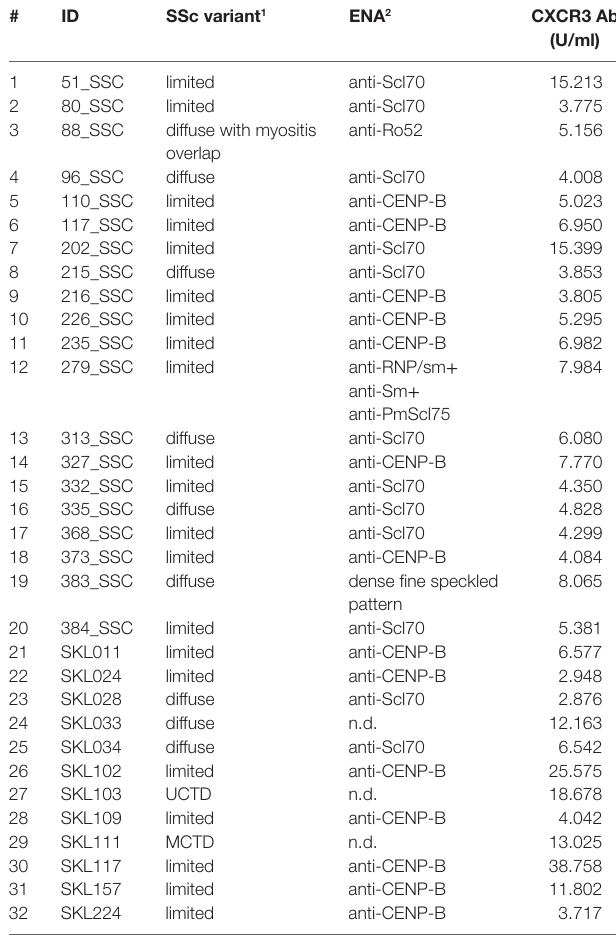
TaBle 1 | Systemic sclerosis patient